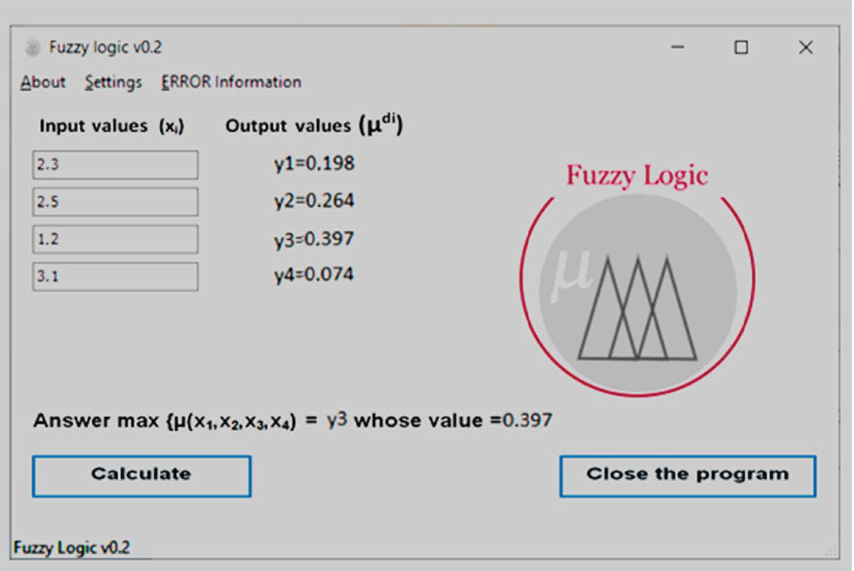
Figure 7. An example of a dialogue window of a program system for determining the degree of anatomical lesion of the coronary